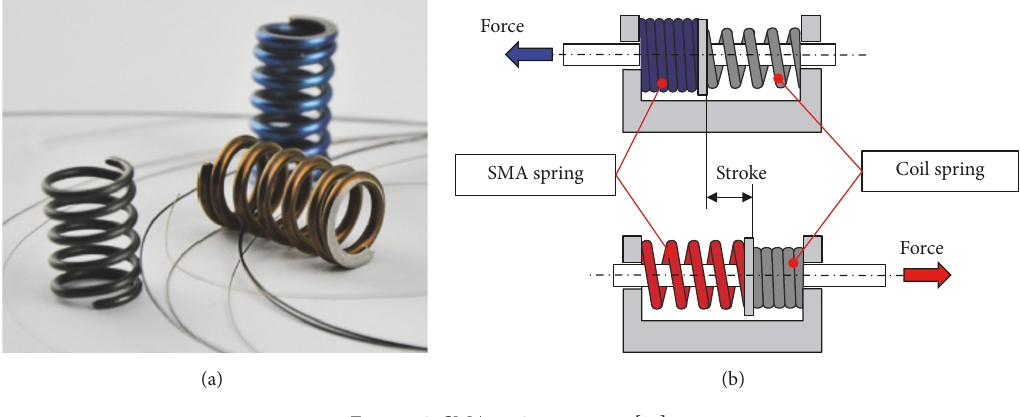
Figure 2: SMA spring actuator